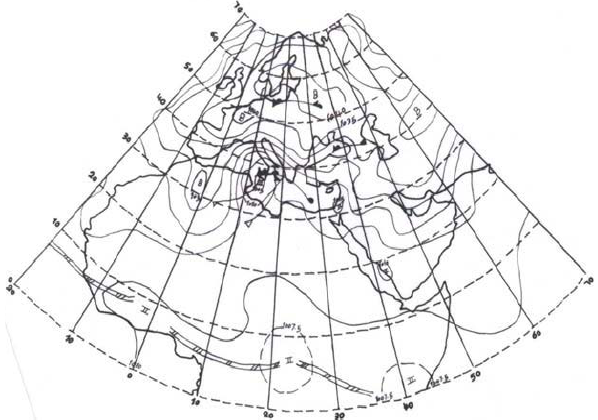
Fig. 14 The pattern of the surface (AAXX) Siberian and Azores isobars 48 hours before the rainfalls (Type IV: 30 December 1984)